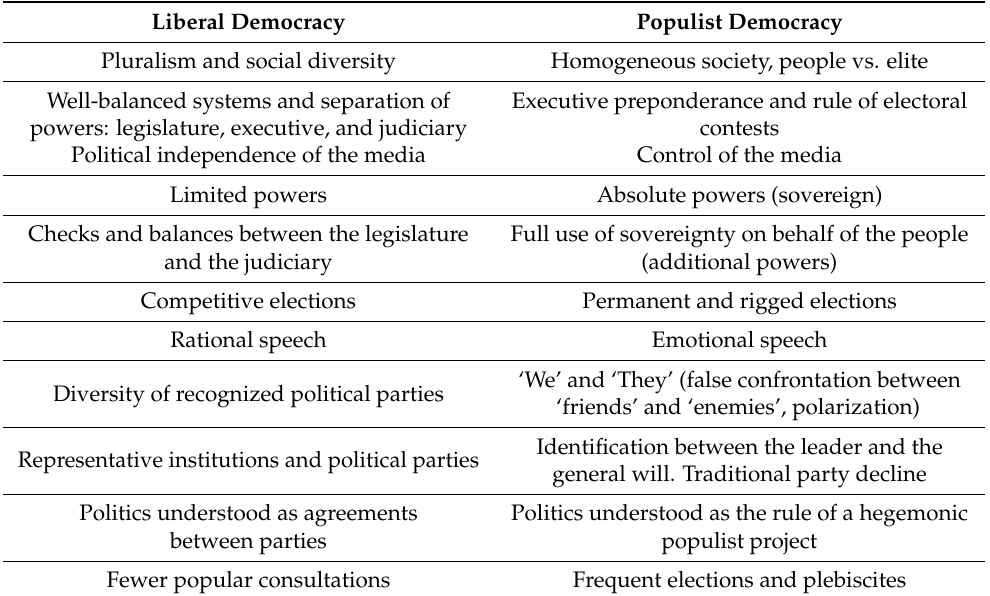
Table 1. Comparison between liberal and populist democracies. Reworked from Mudde and Kalt- wasser